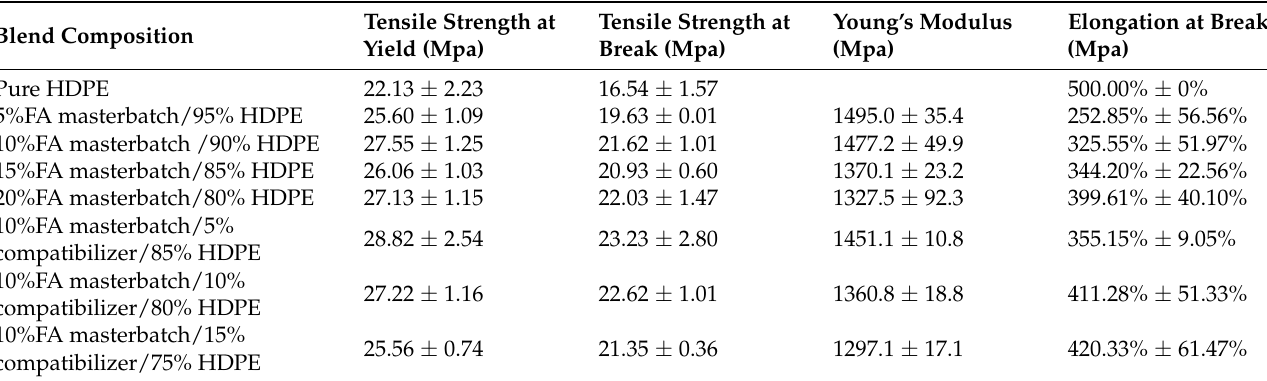
Figure 3. Stress-strain diagrams of different composites [10]. Table 1. Material parameter of composites [10].